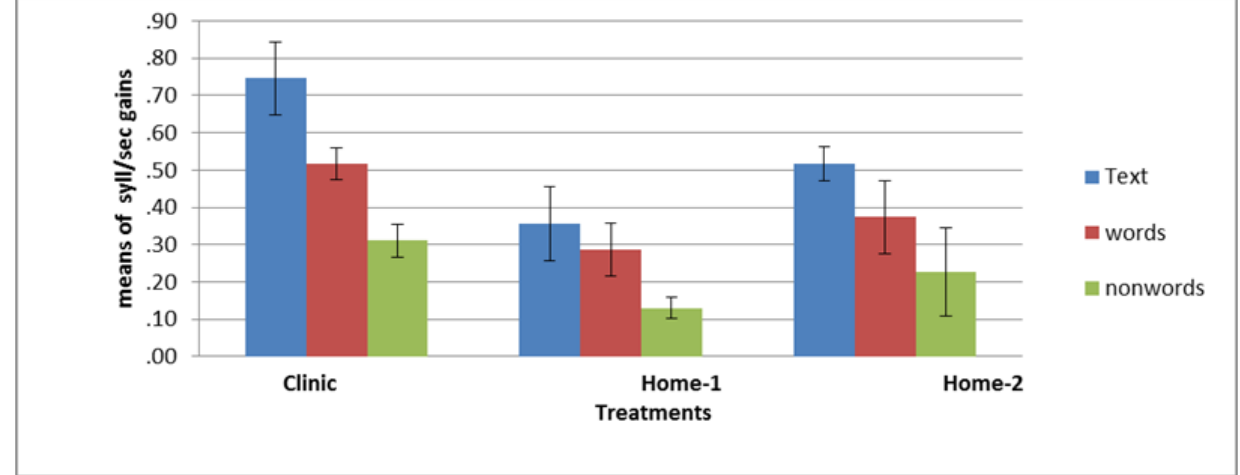
Figure 1. Means of gain scores in fluency, expressed in syll/sec, obtained by the three treatments in reading text, words and nonwords.